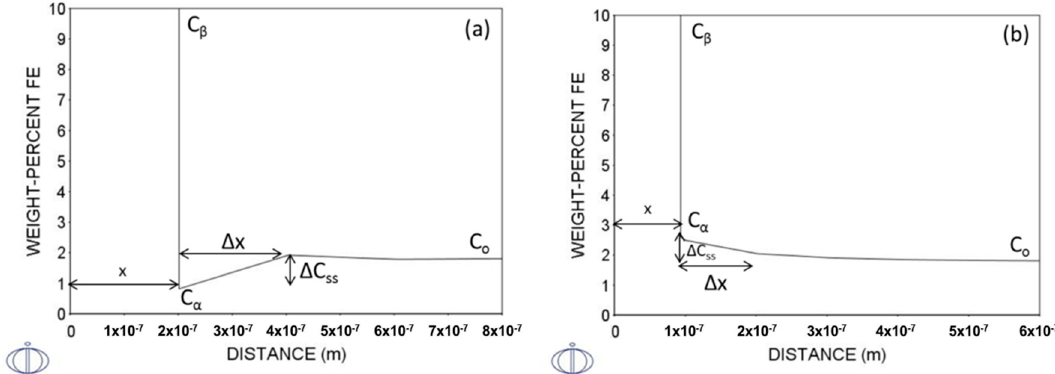
Figure 11. Plot of Fe profiles versus Cu matrix ( a ) growth of Fe particles, ( b ) dissolution of Fe particles. The diagrams are concentrated on the interface thus C β is 90 wt.